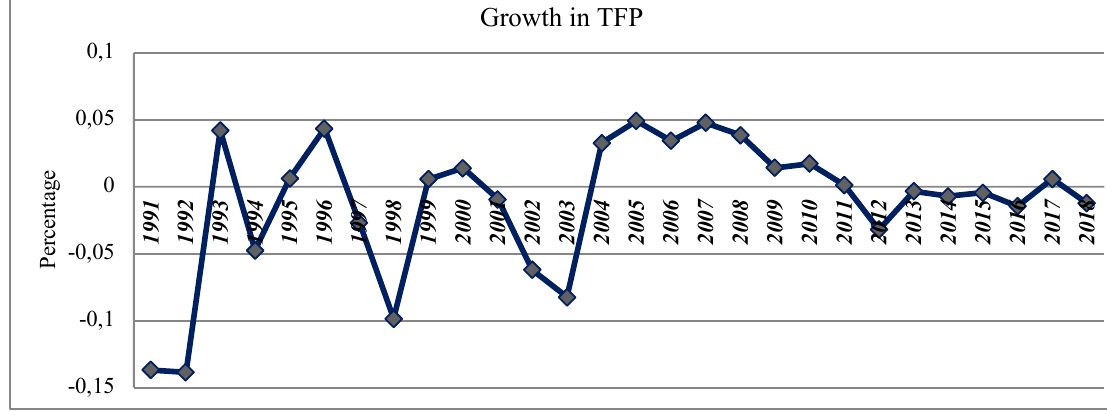
Figure 1: Total factor productivity